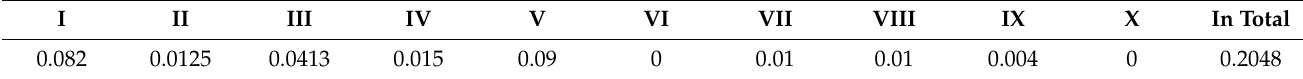
Table A2. Results by items (second area).